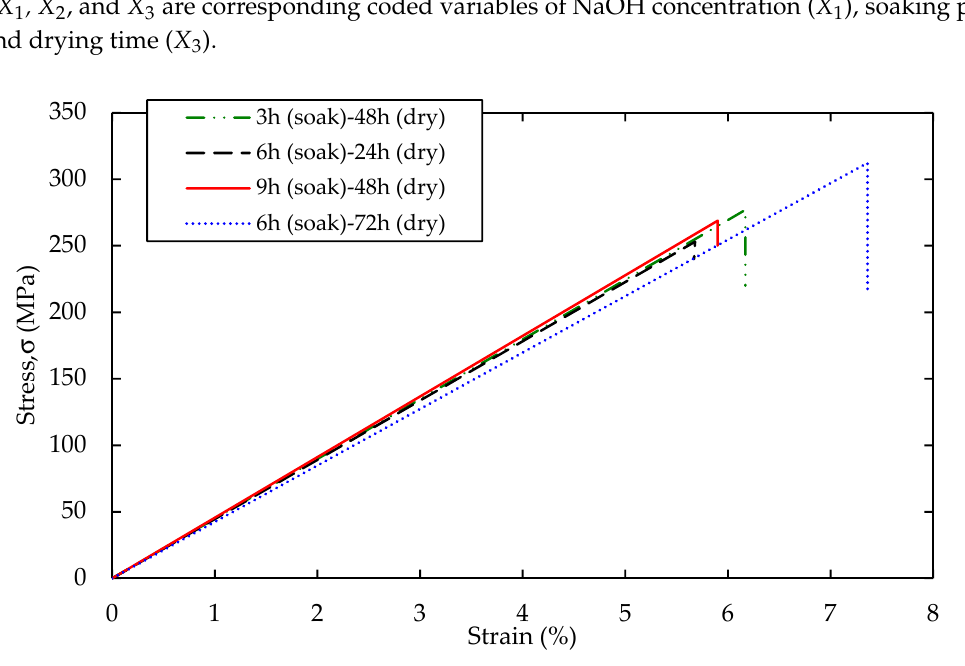
Figure 4. Typical stress-strain curves bamboo reinforced epoxy composites treated with of 3 wt.%, NaOH concentration. Table 4. Box–Behnken Design (BBD) analysis with experimental and predicted values of tensile